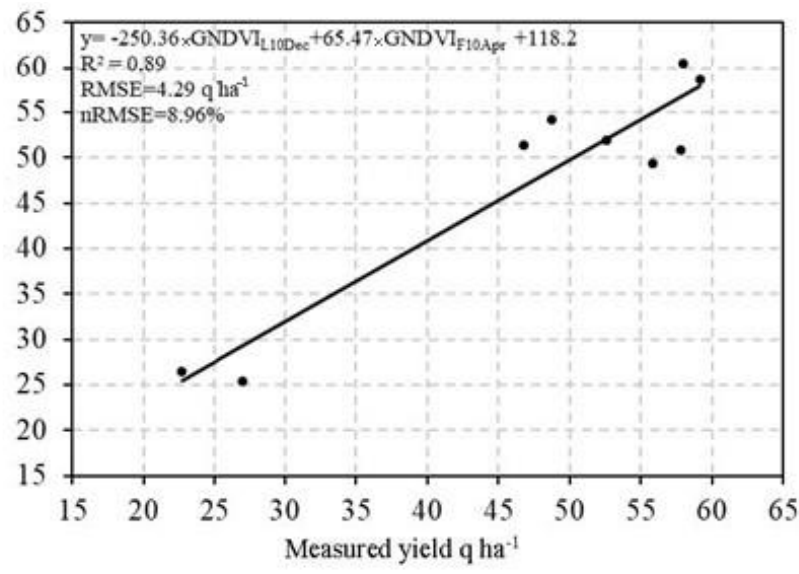
Figure 7. Relationship between measured and retrieved wheat yield. Table 5. The comparison of wheat yield in situ measured and retrieved from remote sensing indices